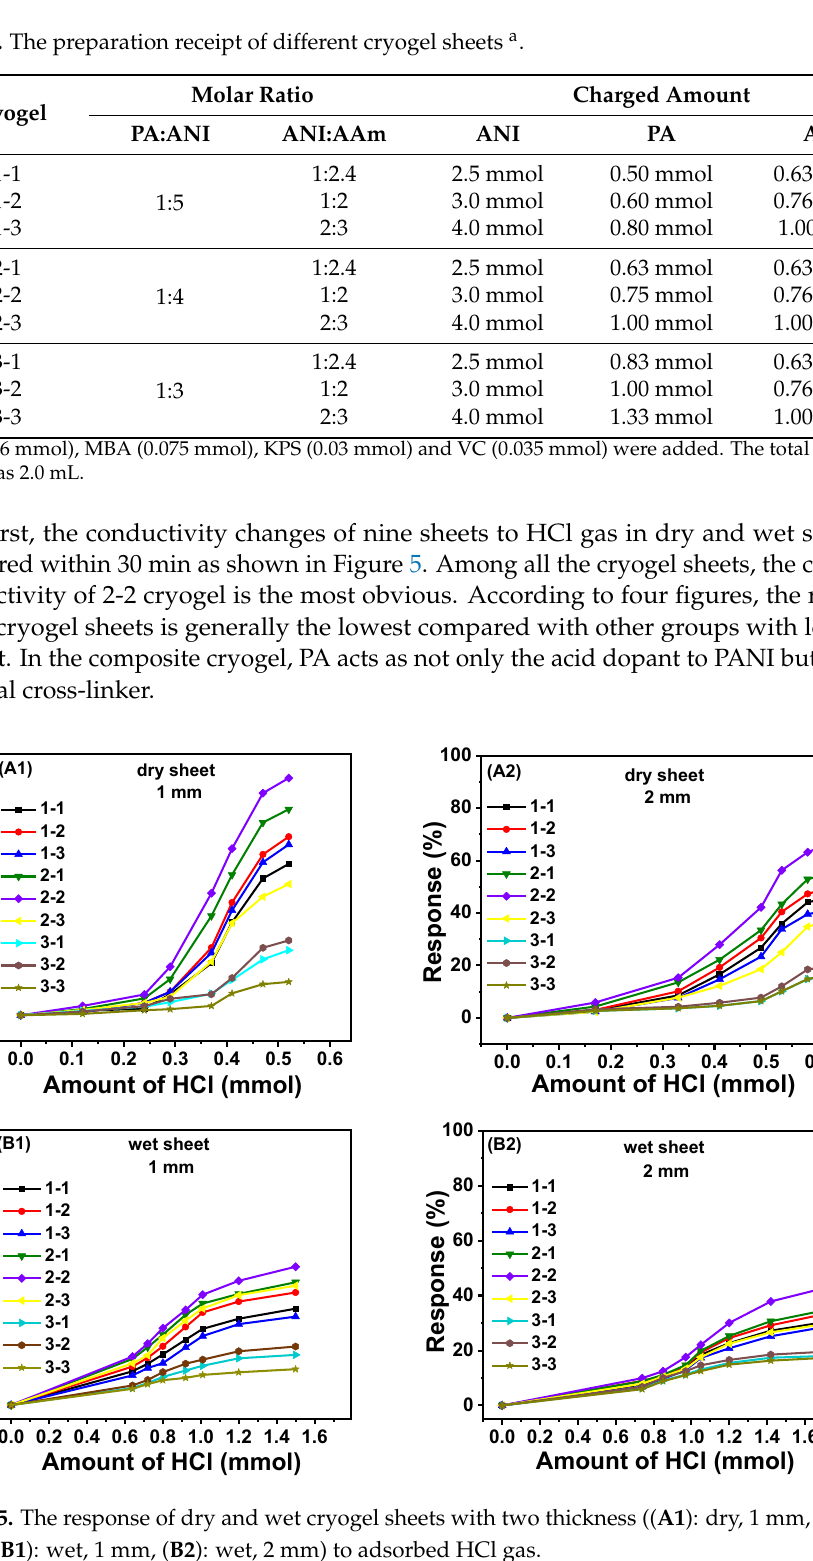
Table 3. The preparation receipt of different cryogel sheets. a . Molar Ratio Charged Amount Cryogel